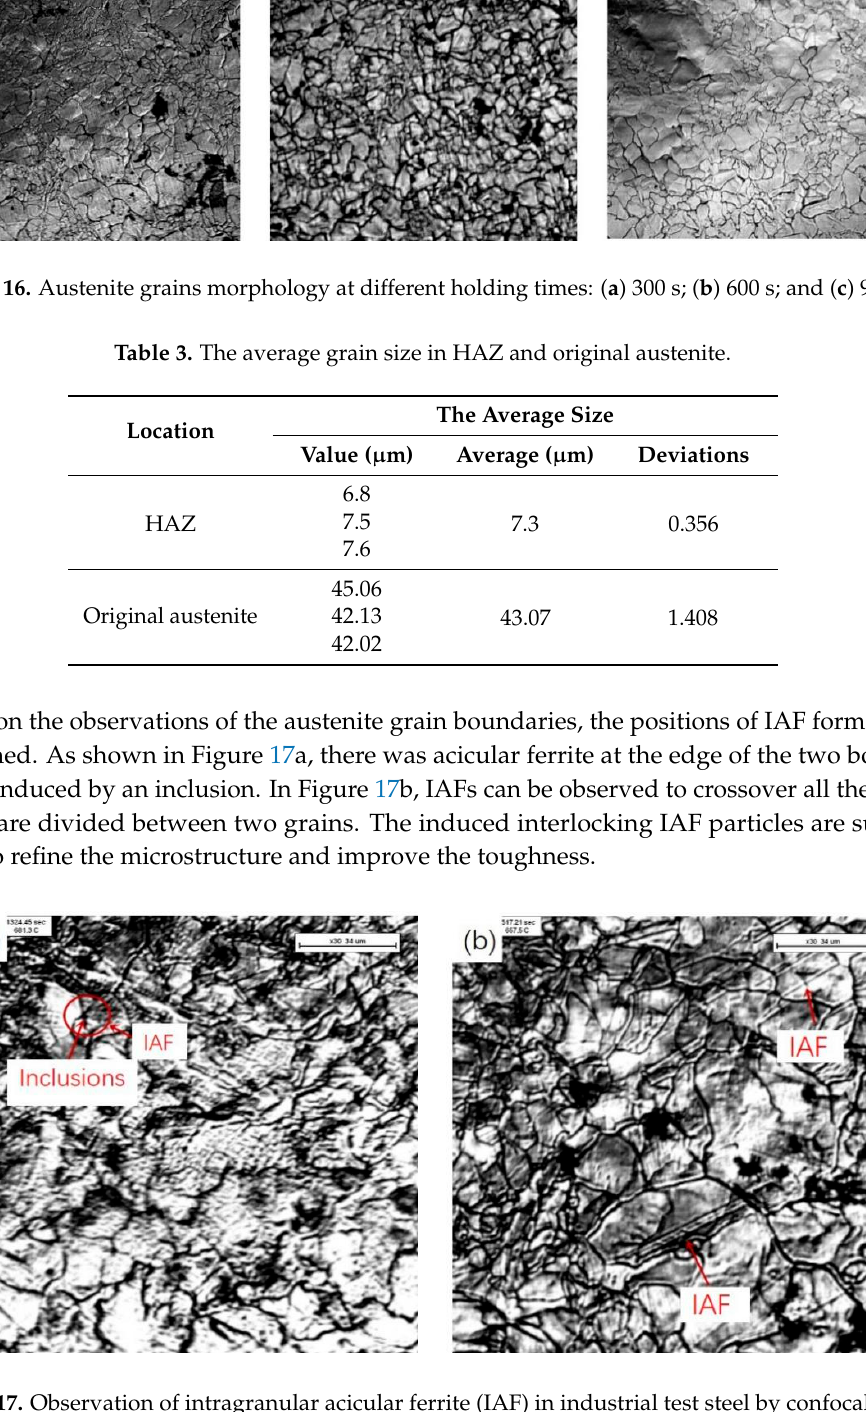
Table 3. The average grain size in HAZ and original austenite.